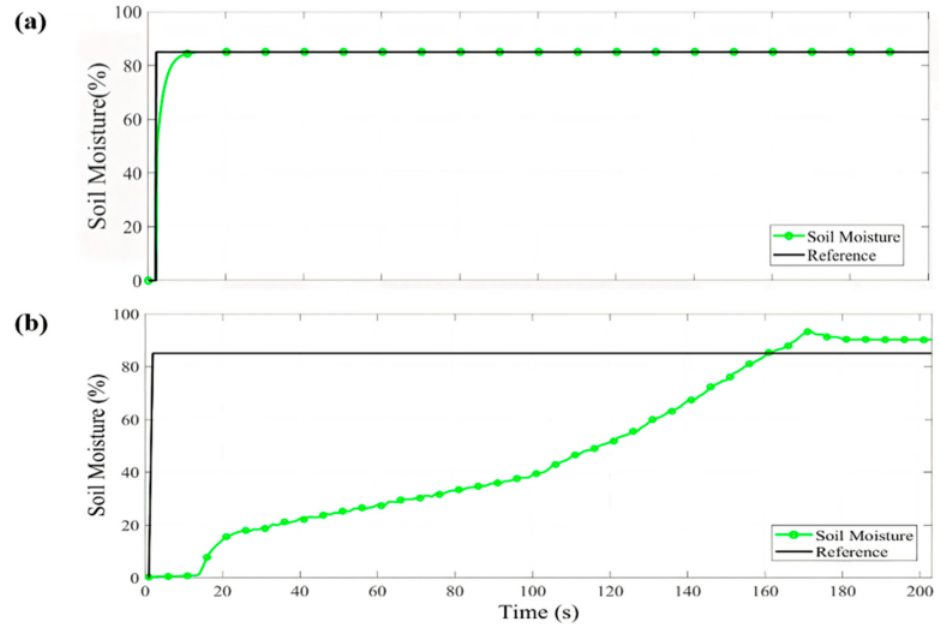
Figure 6. Simulation ( a ) and implementation ( b ) of soil moisture PID